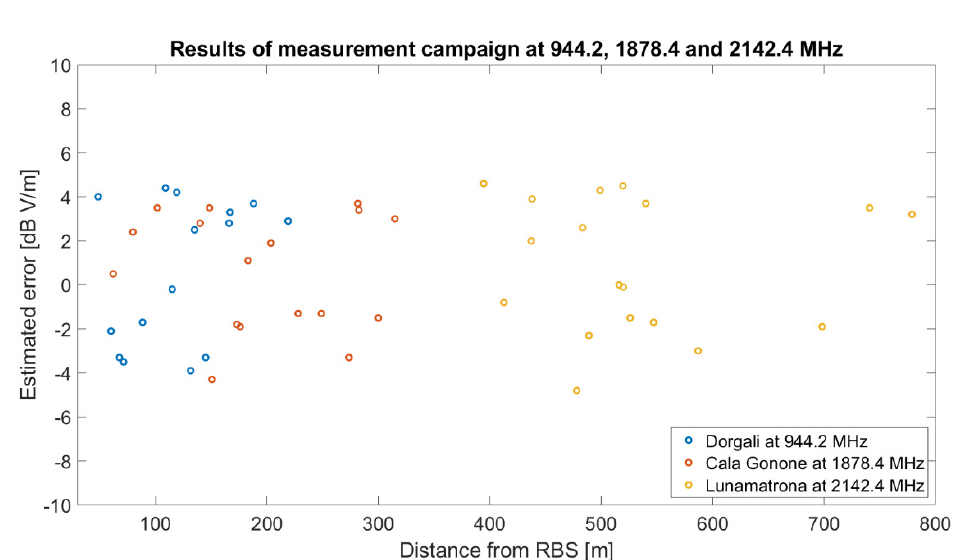
Figure 7. Comparison of the estimated error with our modified version of the C231WI model for the three built-up scenarios of Dorgali (NU, Italy), Cala Gonone (NU, Italy), Lunamatrona (CA, Italy) at the UHF frequencies of 944.2 MHz, 1878.4 MHz and 2142.4